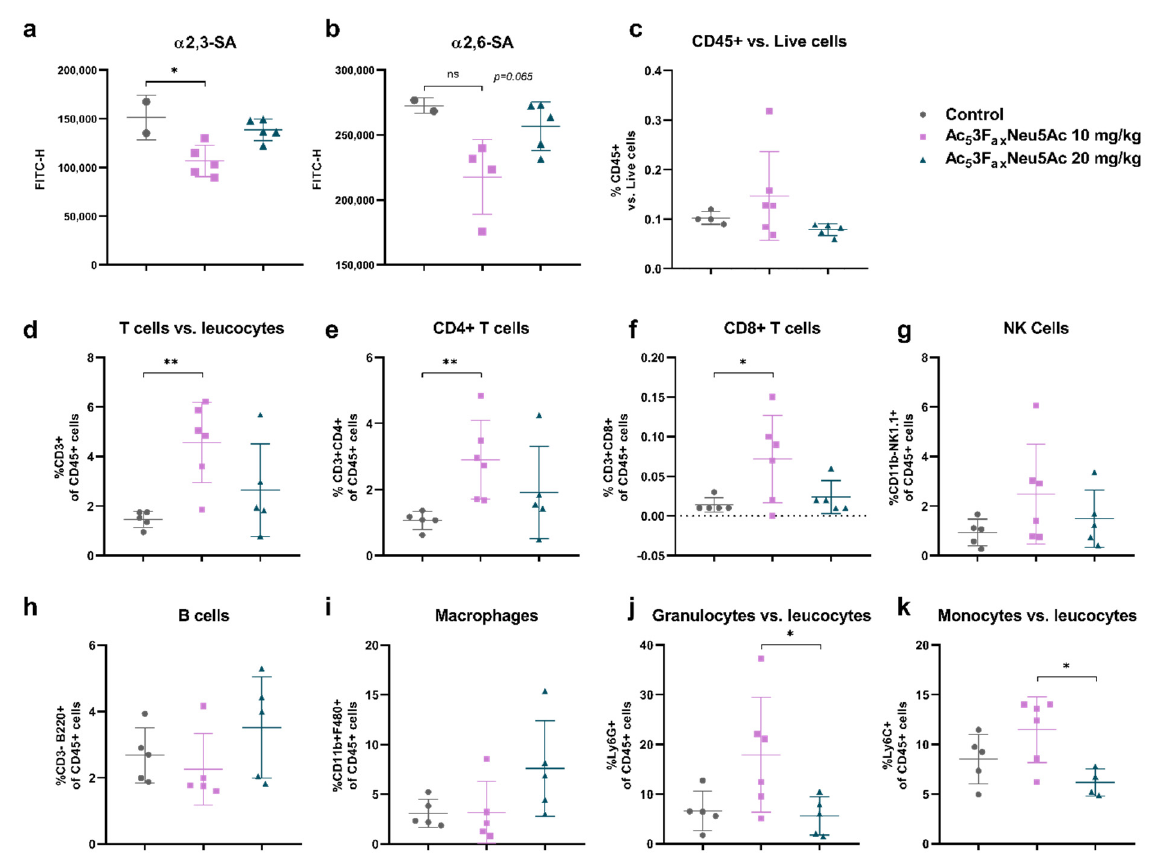
Figure 6. Intratumoral Ac 5 3F ax Neu5Ac injections reduced SA expression of tumor cells and altered the immune cell composition of the tumor. Analysis of cell surface sialoglycans expressed by tumor cells isolated from control, 10 mg/kg and 20 mg/kg Ac 5 3F ax Neu5Ac-treated tumors by flow cytometry. Dot plots showing mean ± SD of ( a ) α 2,6-SA and ( b ) α 2,3-SA levels of the different treatment groups ( n = 2 for control; n = 6 for 10 mg/kg and n = 5 for 20 mg/kg Ac 5 3F ax Neu5Ac). ( c – j ) Analysis of immune cells of the different treatment groups ( n = 5 for control; n = 6 for 10 mg/kg and n = 5 for 20 mg/kg Ac 5 3F ax Neu5Ac), dot plots showing mean ± SD of ( c ) CD45 + immune infiltrates, ( d ) CD3 + T cells, ( e ) CD4 + T cells, ( f ) CD8 + T cells, ( g ) CD11b + NK1.1 + cells, ( h ) CD3-B220 + B cells, ( i ) CD11b + F480 + macrophages, and ( j ) Ly6G + or ( k ) Ly6C + myeloid cells in the tumors of the different treatment groups. * p < 0.05 and ** p < 0.01. ns: no significance.